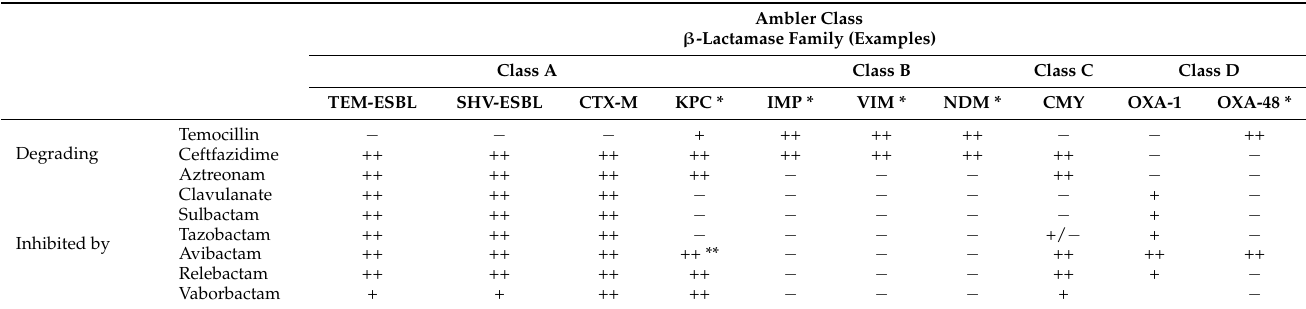
Table 2. Effect on different β -lactams and inhibitor activities against a selection of β -lactamase-families. Based on data from